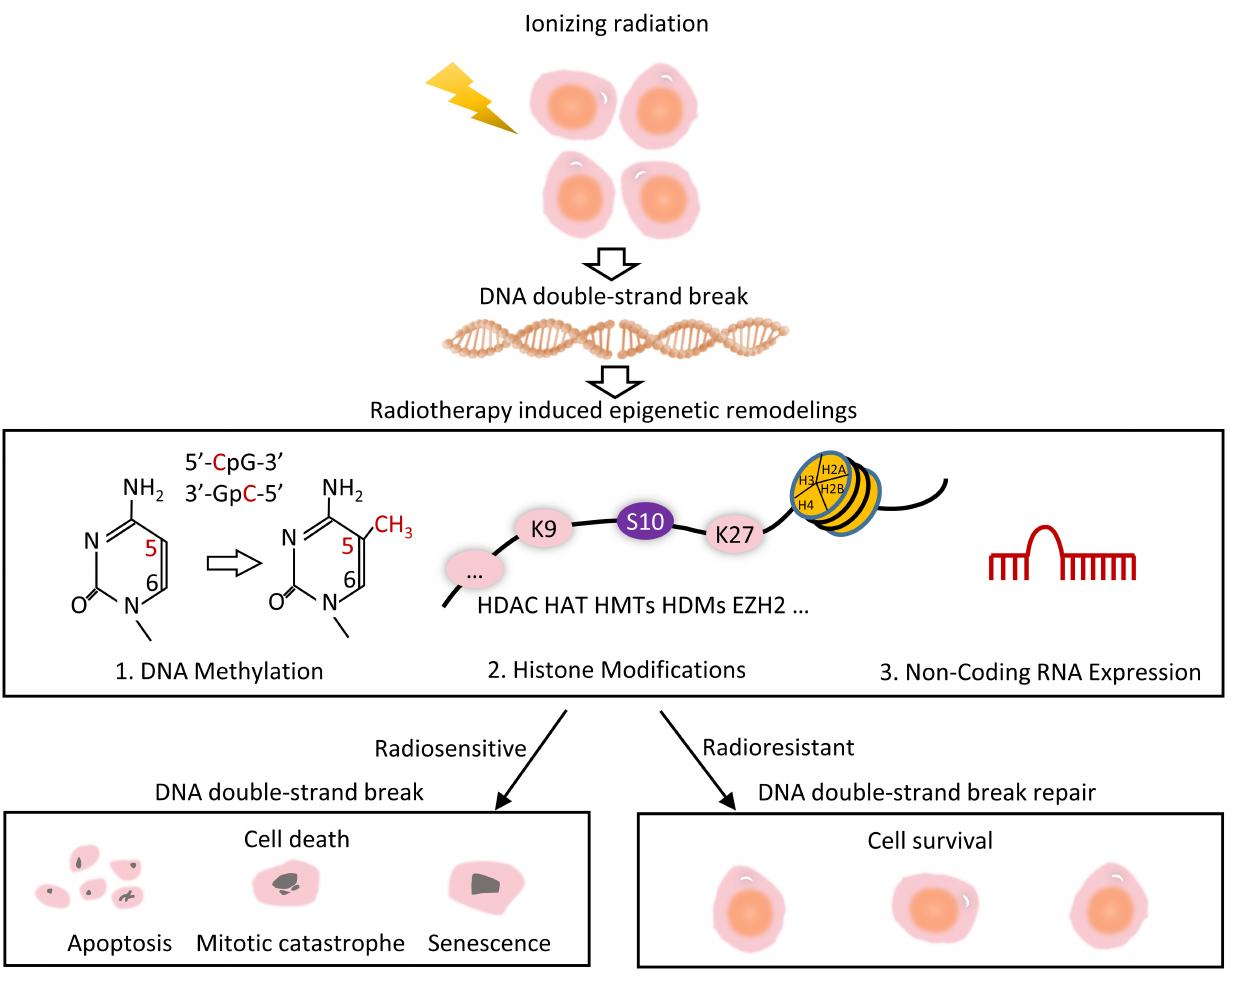
Frontiers in Cell and Developmental Biology |